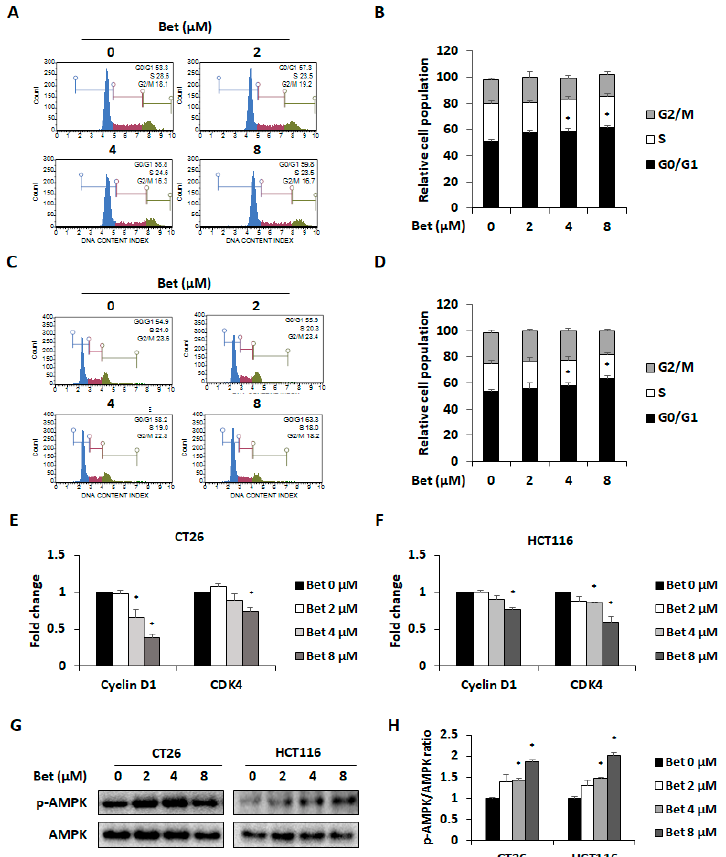
Figure 2. Betulin induces G0 / G1 arrest through cyclin D1 and CDK4 downregulation in metastatic colorectal cancer cells. Cell cycle phase distribution ( A ) and relative cell population ( B ) of betulin-treated CT26 cells as determined by flow cytometry. Cell cycle phase distribution ( C ) and relative cell population ( D ) of betulin-treated HCT116 cells. Expression of cyclin D1 and CDK4 in betulin-treated CT26 ( E ) and HCT116 ( F ) cells. AMPK phosphorylation detected in betulin-treated CT26 ( G ) and HCT116 ( H ) cells. Images represent three independent experiments. Data are means ± standard deviation of three independent experiments. * p < 0.05.